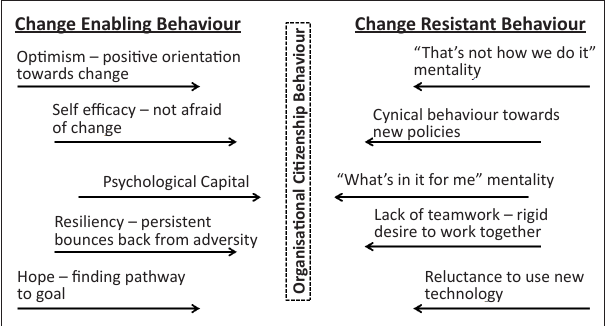
FIGURE 4: Drivers of, and resisters to, change in